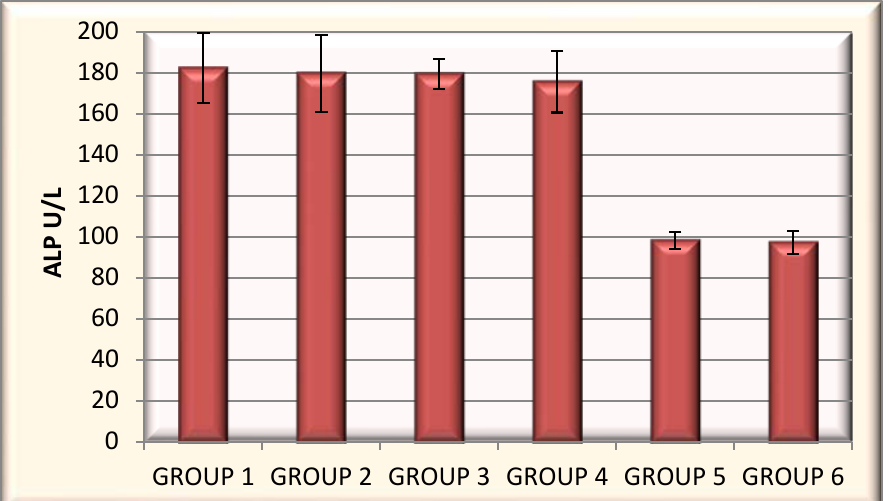
Figure 11. Mean alkaline phosphatase values for the encapsulated samples from the six groups of animals.